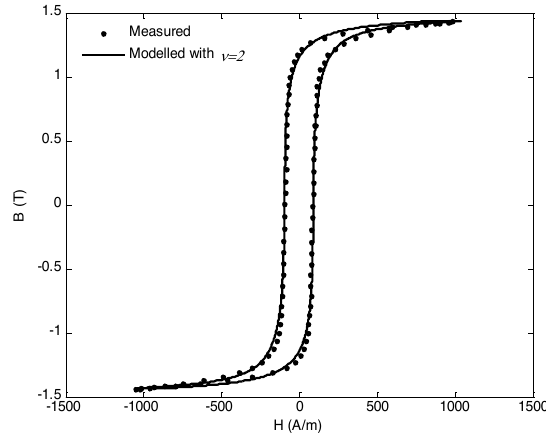
FIGURE 3. Modelled and measured hysteresis loops at 100 Hz When the frequency is increased more than 100 Hz a swelling appears on the shape of the measured hysteresis loops. This swelling becomes more and more visible for higher frequencies as shown in Figs 4-6. Figs. 4-6, show that when we use n =2, dynamic hysteresis loops modelled for increased frequency do not fit measured